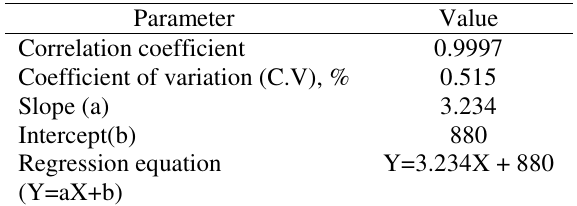
Table 4 . Statistical